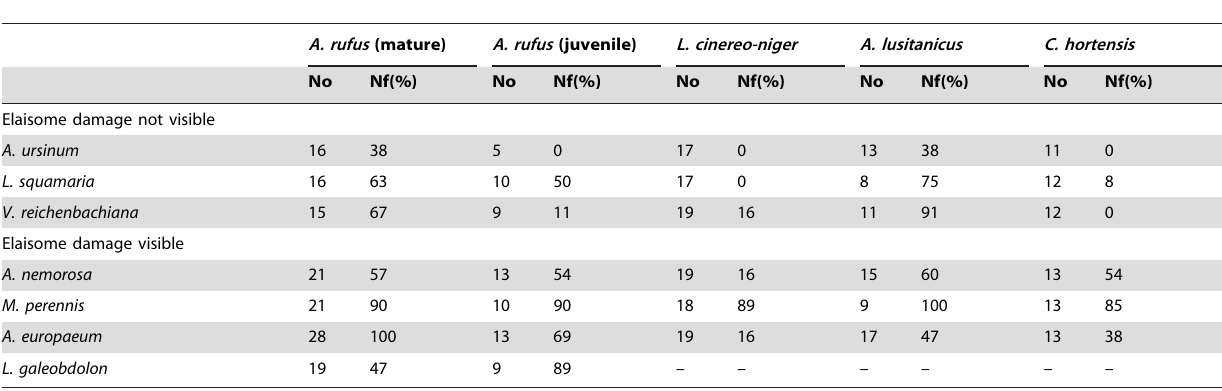
Table 1. Number of gastropod individuals to which diaspores of certain plant species were offered (No) and proportion of individuals that fed on the diaspores